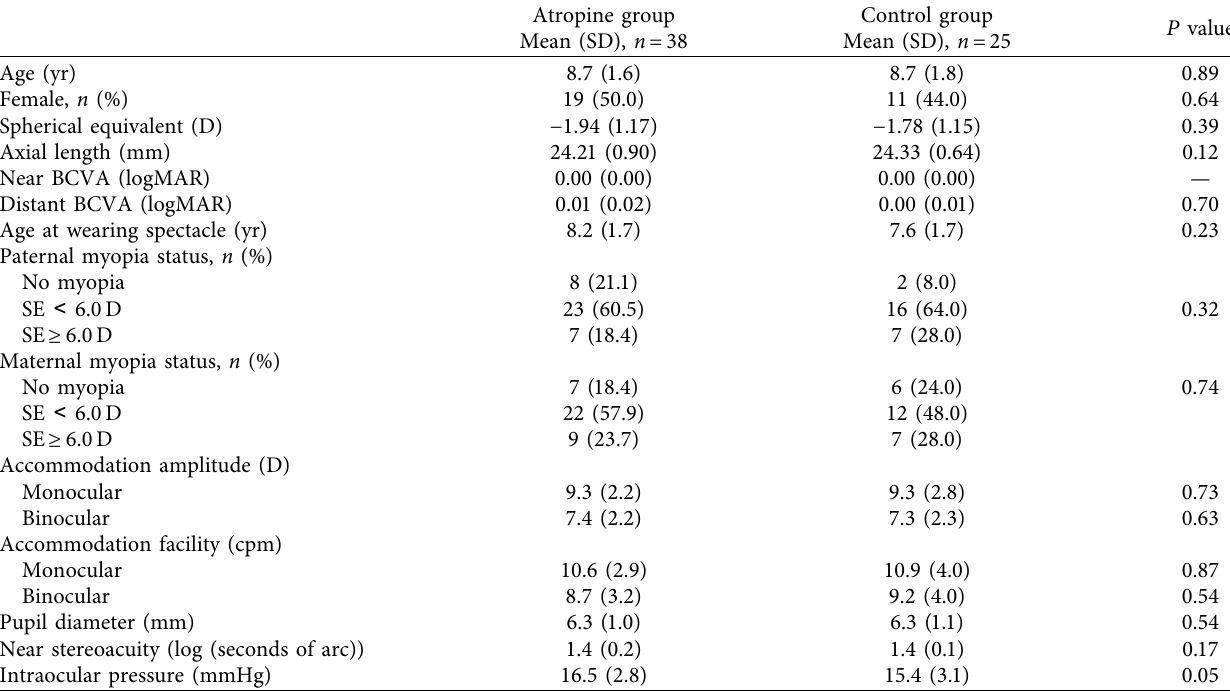
Table 2: Baseline characteristics of the children in the two study